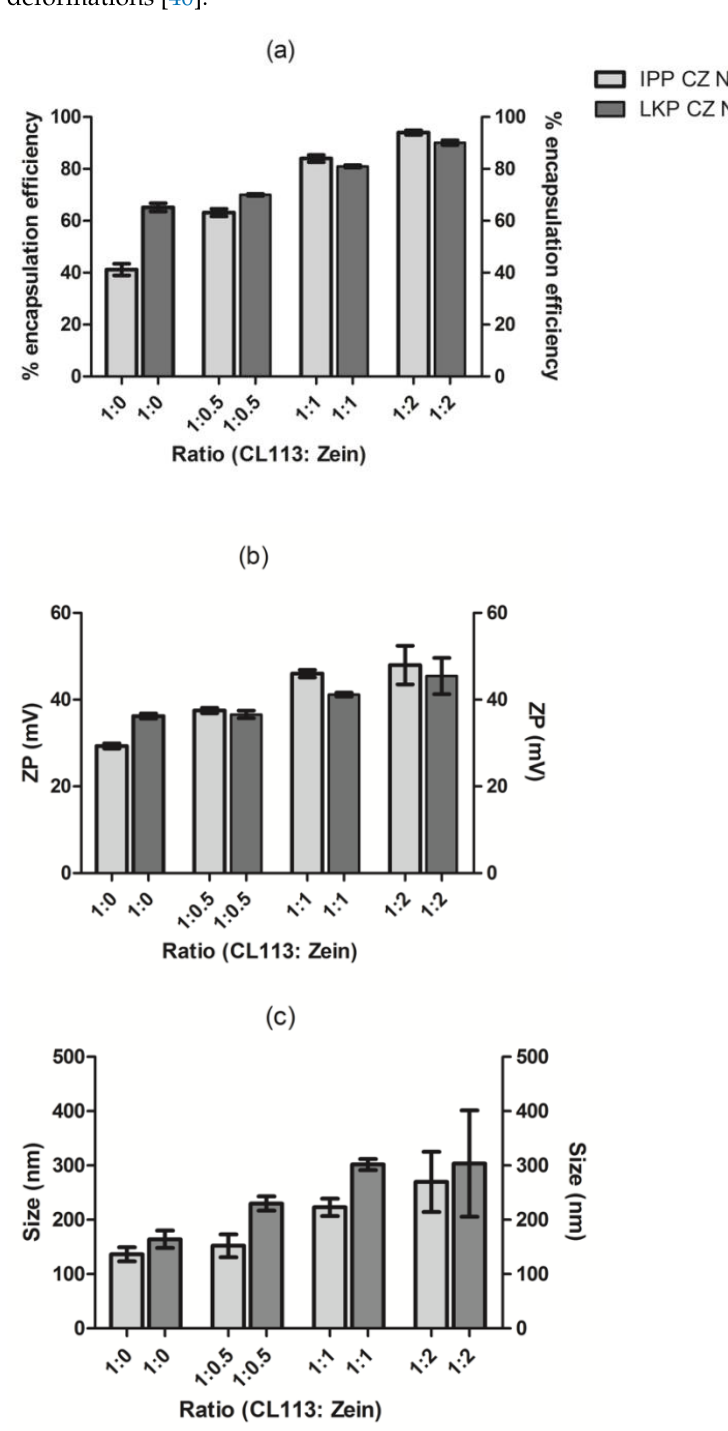
Figure 1. The effect of ( a ) EE (%), ( b ) ZP (mV) and ( c ) size (nm) at varying ratio of CL113: zein (from Figure 1: The effect of (a) EE (%), (b) ZP (mV) and (c) size (nm) at varying ratio of 1:0 to 1:2) for CZ NP. Data are expressed as a mean ± SD of n = CL113: zein (from 1:0 to 1:2) for CZ NPs. Data are expressed as a mean ±SD of n = 3.